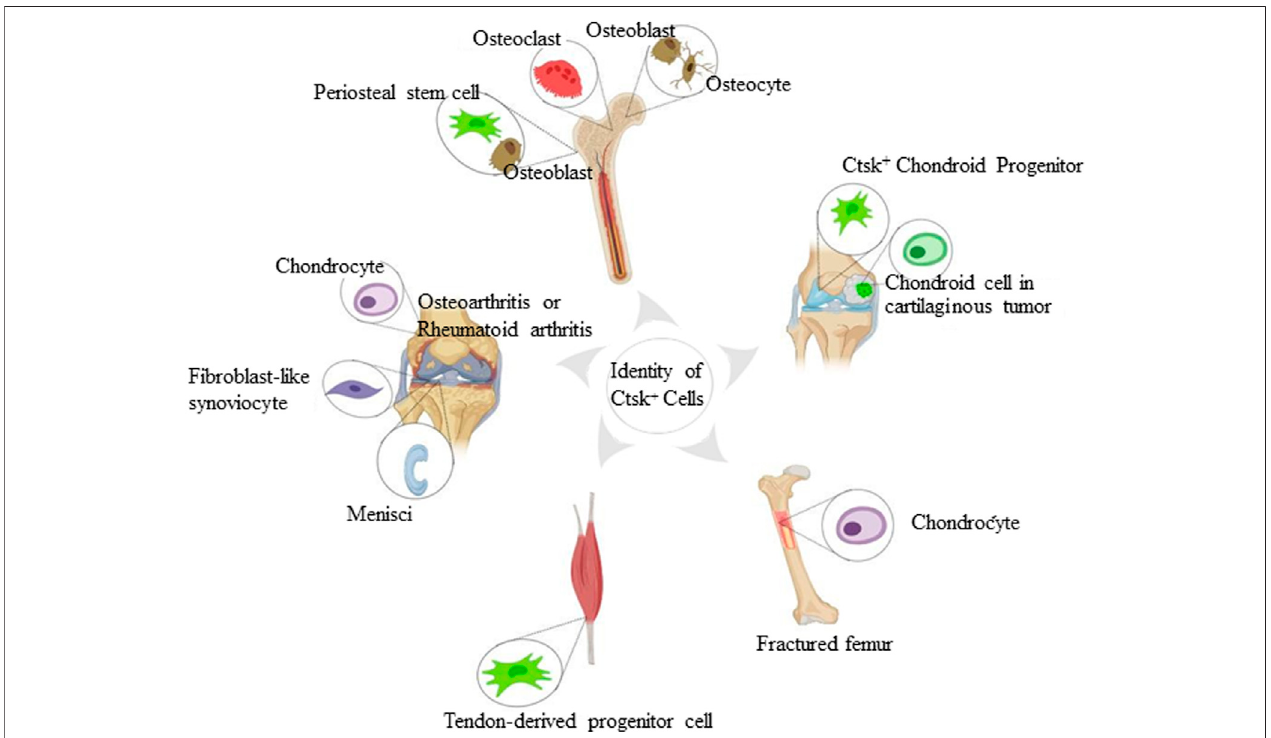
FIGURE 1 | Identity of Ctsk + cells found in the skeletal system. The schematic depiction shows subsets of Ctsk + cells, including mature osteoclasts, osteoblasts, osteocytes, chondrocytes, and some mesenchymal stem/progenitor cells. Mature osteoclasts, osteoblasts, and osteocytes are displayed according to Ctsk immunostaining. Ctsk + YFP + stem/progenitor cells are represented in